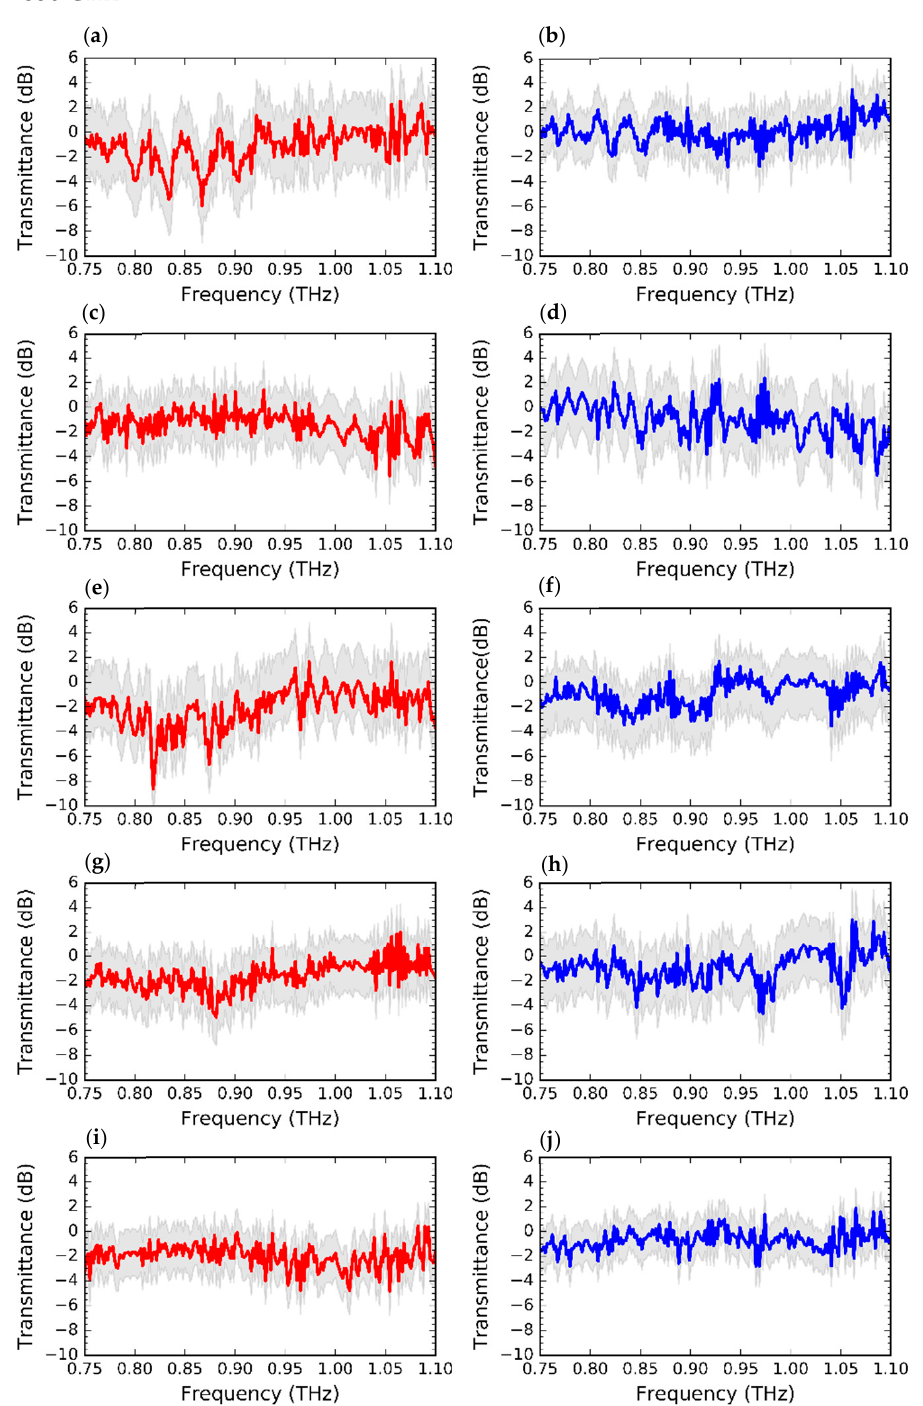
Figure 7. Measured transmittance of the fabricated waveguides: ( a ) 1 cm unclad waveguide; ( b ) 1 cm EM waveguide; ( c ) 2 cm unclad waveguide; ( d ) 2 cm EM waveguide; ( e ) 3 cm unclad waveguide; ( f ) 3 cm EM waveguide; ( g ) 4 cm unclad waveguide; ( h ) 4 cm EM waveguide; ( i ) 5 cm unclad waveguide; ( j ) 5 cm EM waveguide.